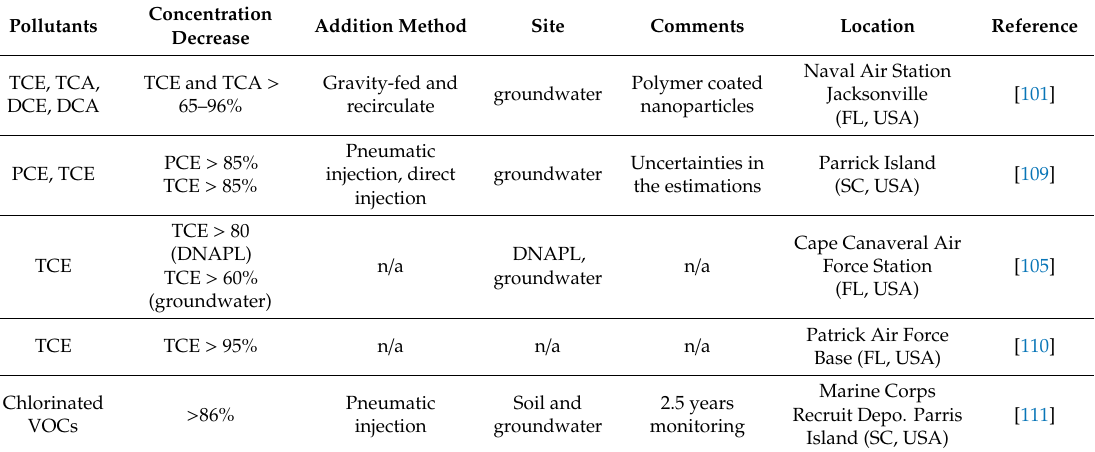
Table 4. Summary of pilot and full scale tests for emulsified zero-valent iron